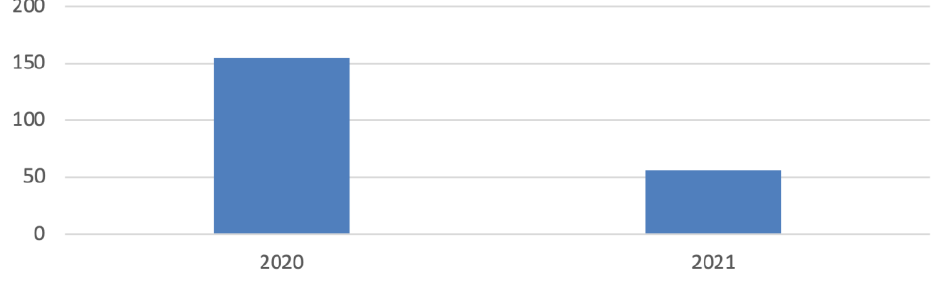
Figure 3 : Publications by year; Source: Research data